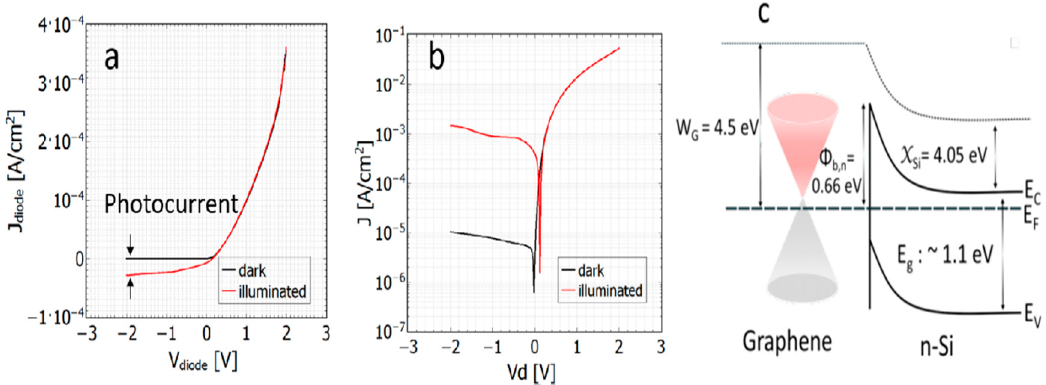
Figure 2. J-V plot of the graphene/n-Si diode on ( a ) linear and ( b ) semi-logarithmic scale in the dark and under illumination; ( c ) the graphene/n-Si interface at zero bias voltage. E C , E V , E F , E g , W G , χ Si and Φ b indicate conduction band, valence band, Fermi level, bandgap, graphene work function, Si electron affinity and Schottky barrier height, respectively [36].